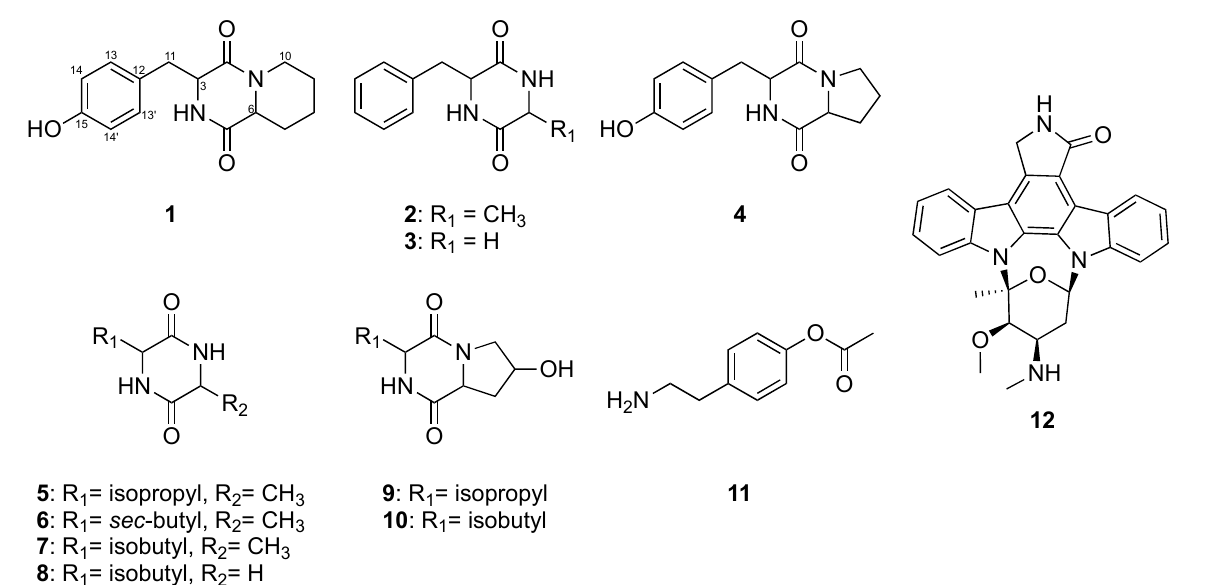
Figure 2. The identified compounds ( 1 – 12 ) from EtOAc extract of Streptomyces sp. LY1209.